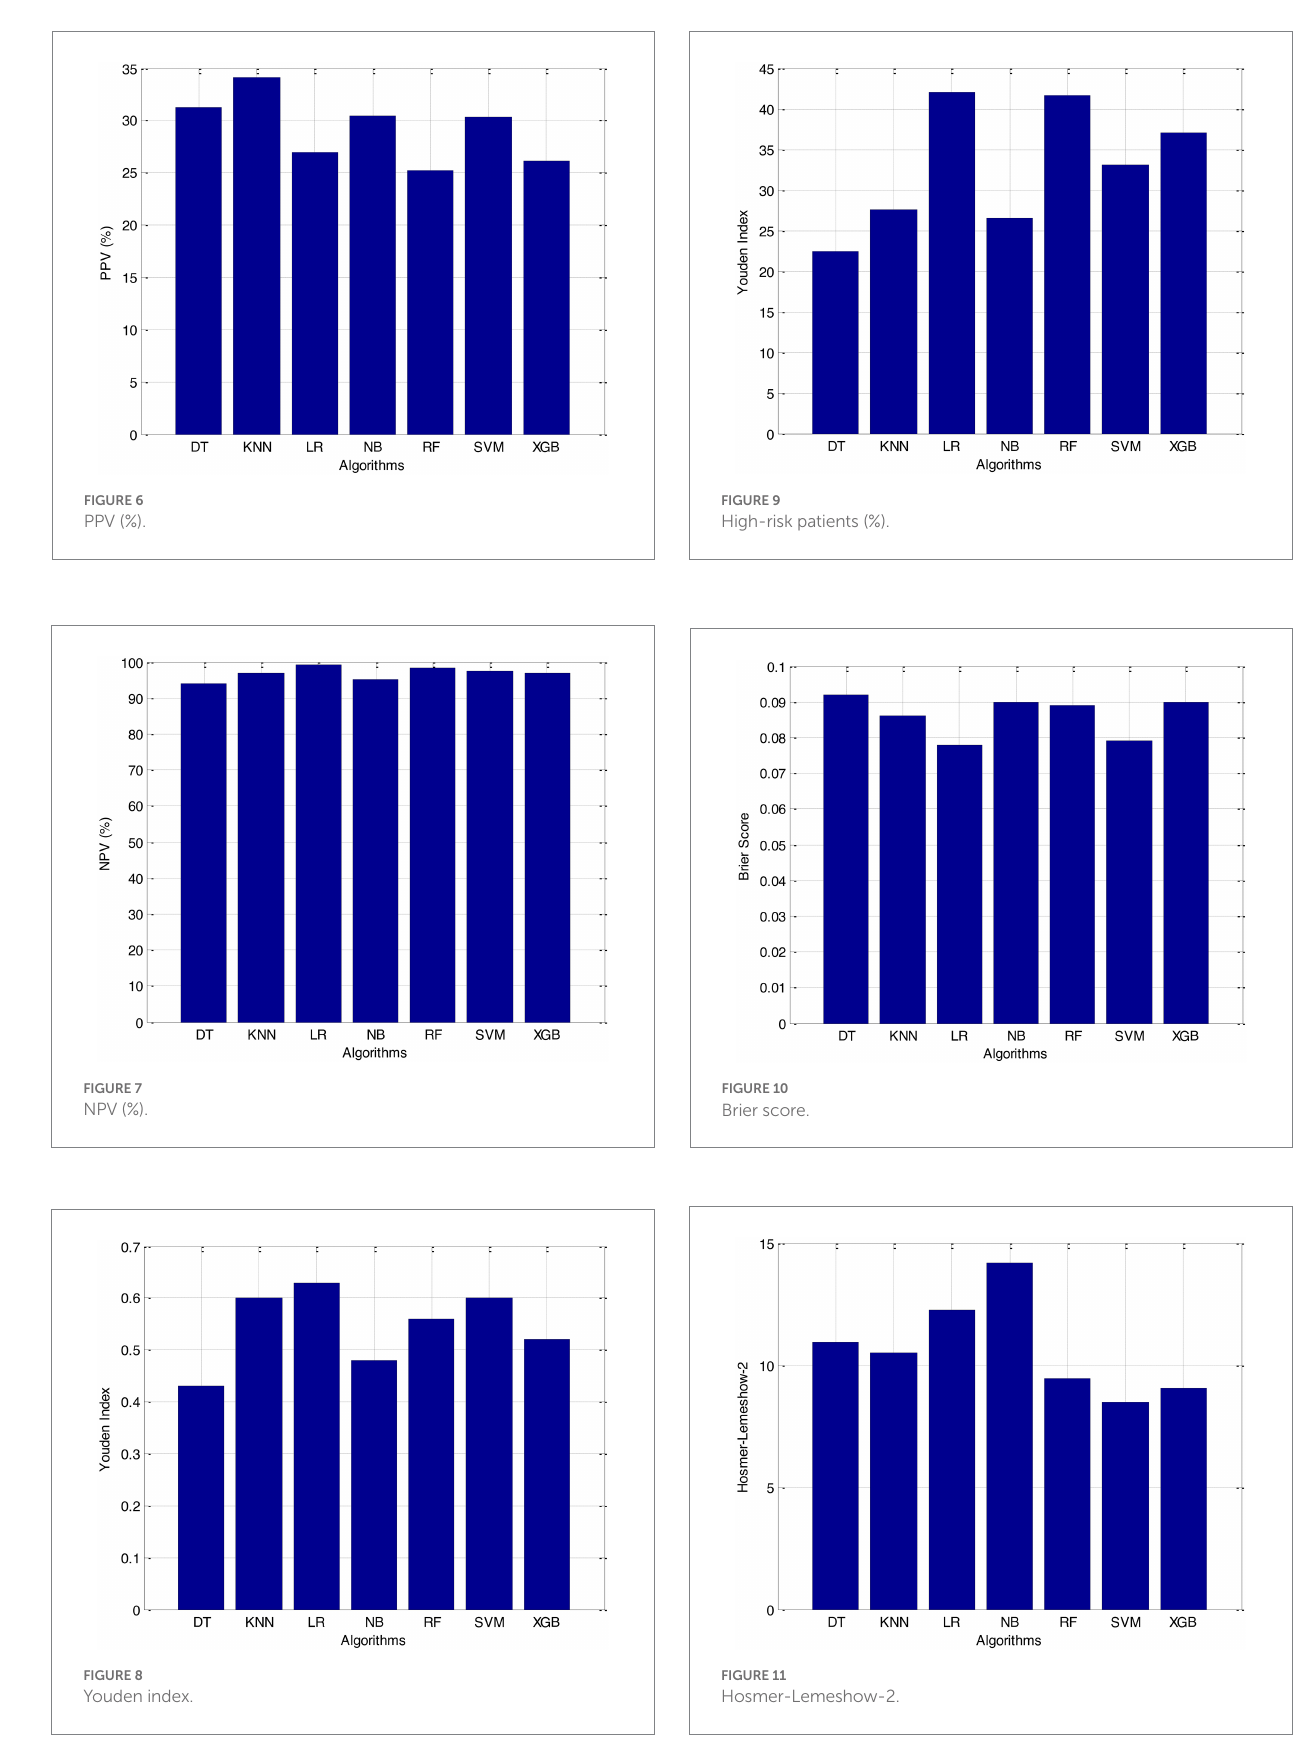
FIGURE 8 Youden index.